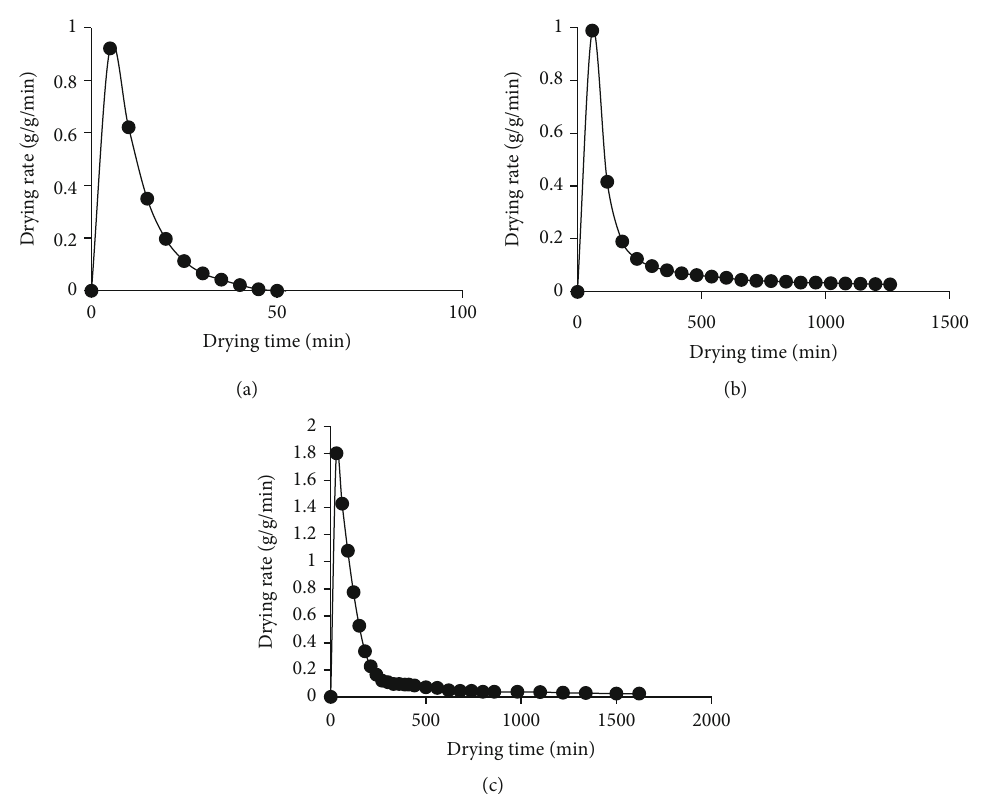
Figure 2: Drying rate curves for refractance window drying (RWD) (a), oven drying (b), and solar drying